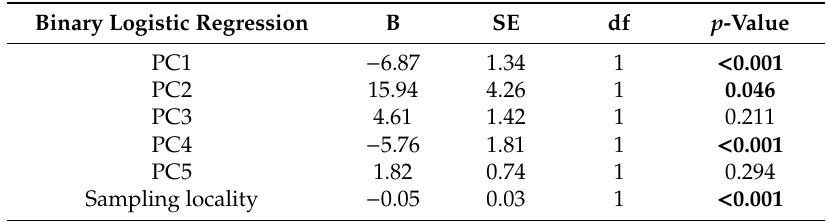
Table 4. Results of the binary logistic regression used to determine the number of independent genetic clusters. The analysis was run with cytochrome c oxidase subunit I (COI)-defined clades as the dependent variable and the principal components and locality as covariates. B is the unstandardized regression weight, SE the standard error and df the degree of